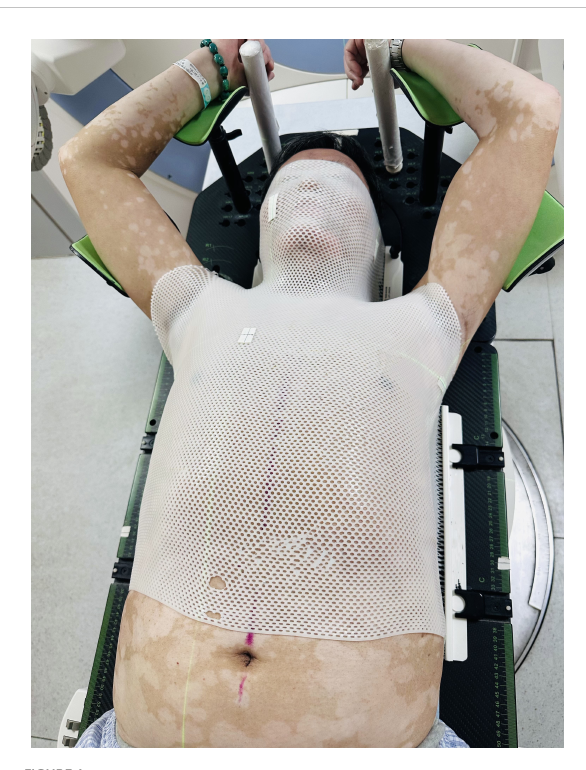
FIGURE 1 Illustration of the setup using the integrated cervicothoracic immobilization devices (ICTID) with arms on brackets.